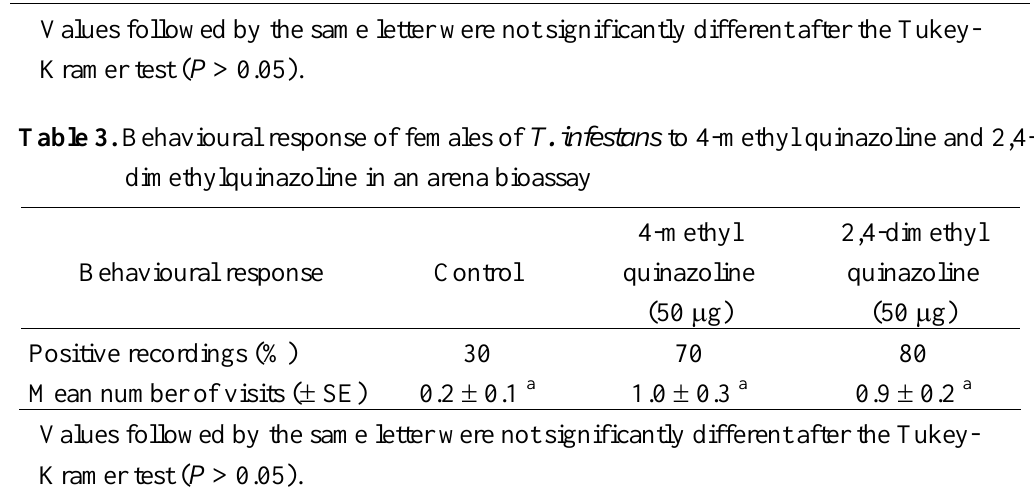
Mean number of visits ( ± SE)